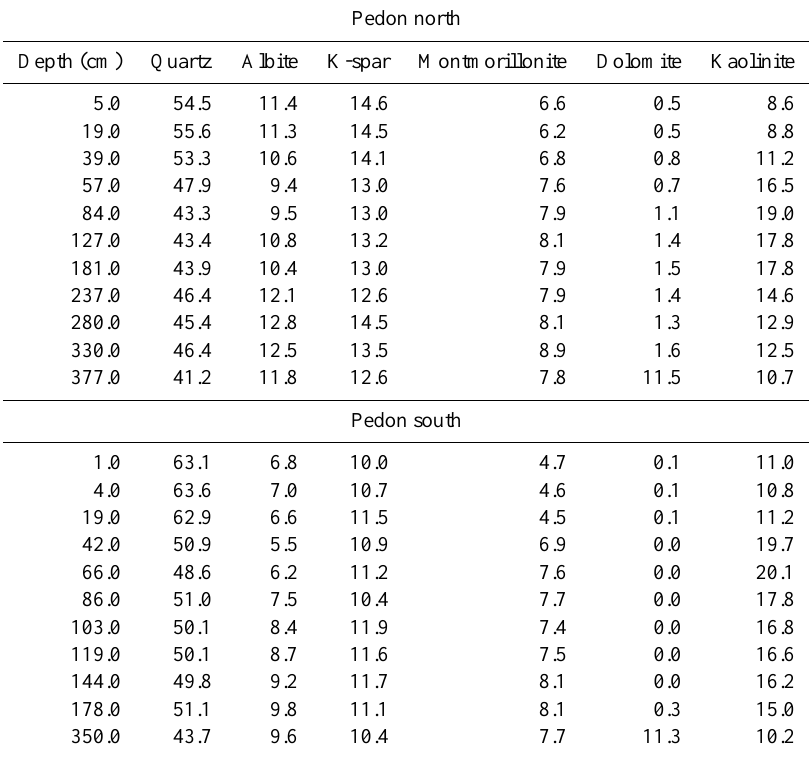
Table 1. Pedon mineralogy (%) assumed for pedon north (42 ◦ 59 0 N) and pedon south (30 ◦ 47 0 N). Pedon north Depth (cm) Quartz Albite